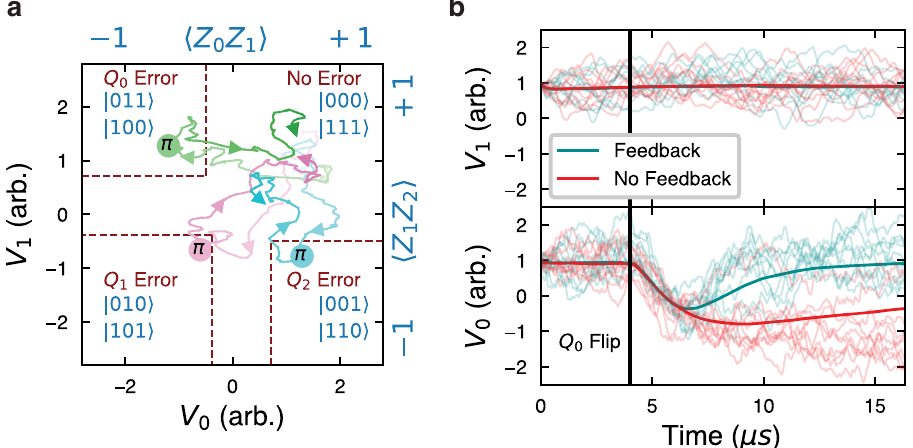
Fig. 2 Error correction. a Sample experimental voltage traces of the controller correcting induced bit fl ips with the system starting in 000 j i . With no errors, both voltages ( V 0 and V 1 ) remain positive. When an error occurs, one or both of the voltages fl ip and the cross thresholds, triggering the controller to send a corrective π pulse to bring the system back to the codespace. b Voltage responses to an induced fl ip on Q 0 with (blue) and without (red) feedback. Bold lines are averages and light lines are sample individual